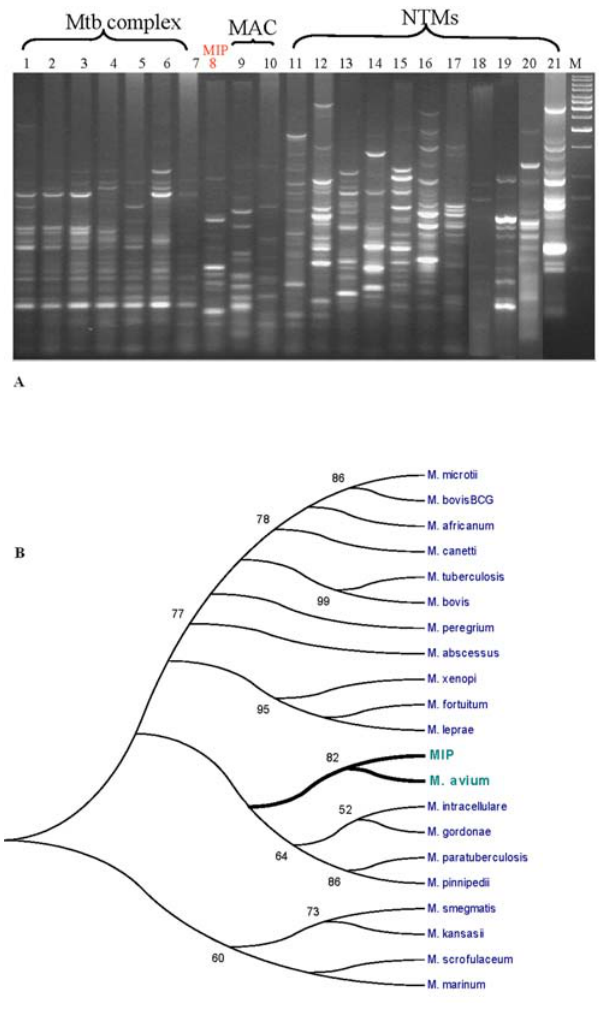
Figure 3. ERIC analysis of MIP,other tubercle bacilli and NTMs. A. ERIC based fingerprinting. B. Phylogenetic analysis. Polymorphic ERIC fragments were subjected to allele calling in Quantity 1 software (Biorad, USA) and scoring was recorded in a binary format. These binary data were used to construct a phylogenetic tree developed using bootstrapping methods in MEGA software. Bootstrap values for the internal branch topology are clearly marked near each branch. Values above 50 were assumed as significant to convey acceptable topology of the internal branches.